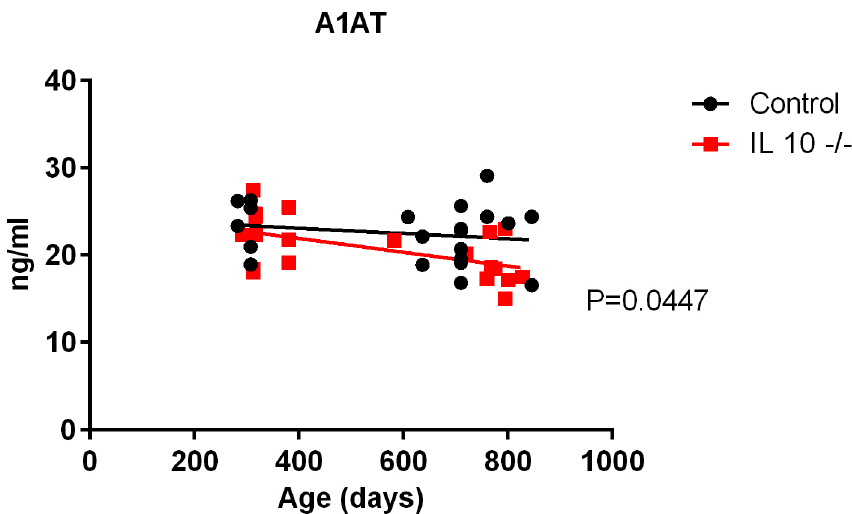
Fig 6. Plasma A1AT levels in IL 10 tm and control